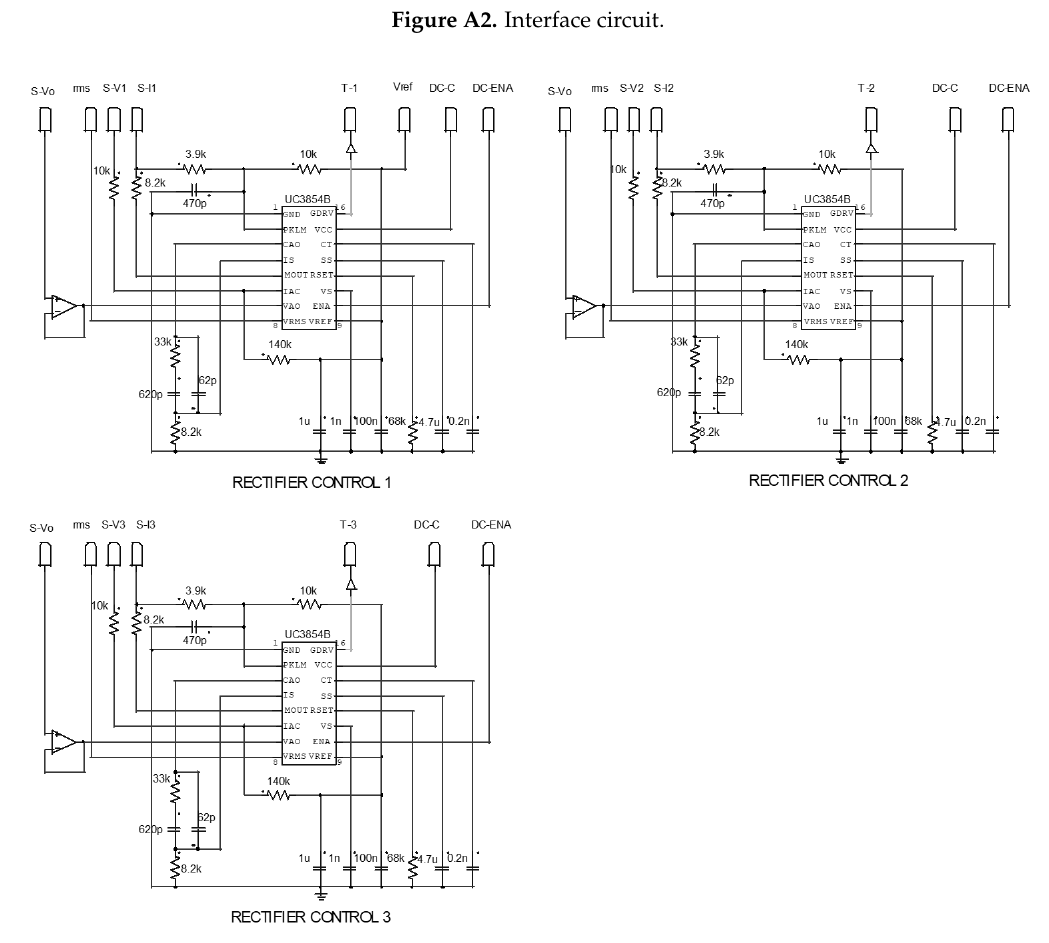
Figure A3. Control Figure A3. Control circuit. Figure A3. Control circuit.